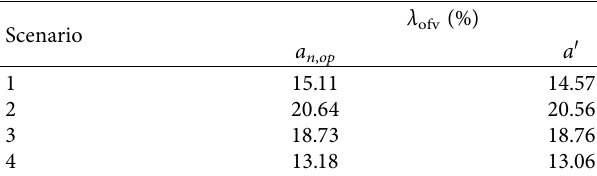
Table 13: Te comparison of the suppression efect of a’ and a